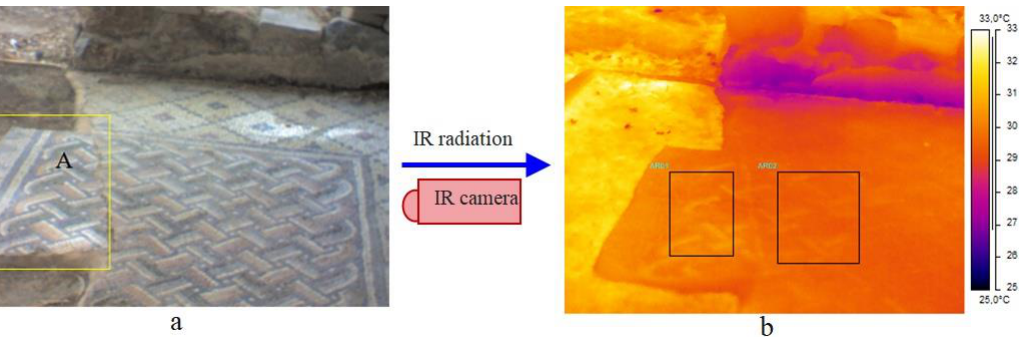
Figure 10. ( a ) View of the mosaic pavement located at the “Sanctuary of Pan”, which is situated on the Pnyx slopes, northwest of Acropolis in Athens, ( b ) representative thermal image. (Reprinted under the terms of the Creative Commons Attribution 3.0 license from Ref. [77]).